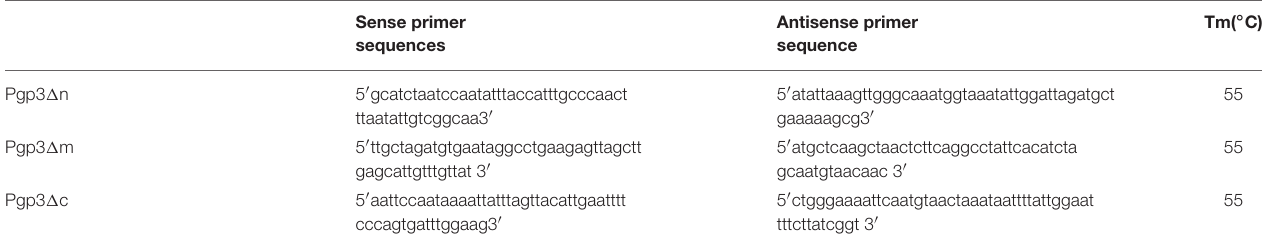
TABLE 1 | The primers for construction of the Pgp3 domain deleted mutants.